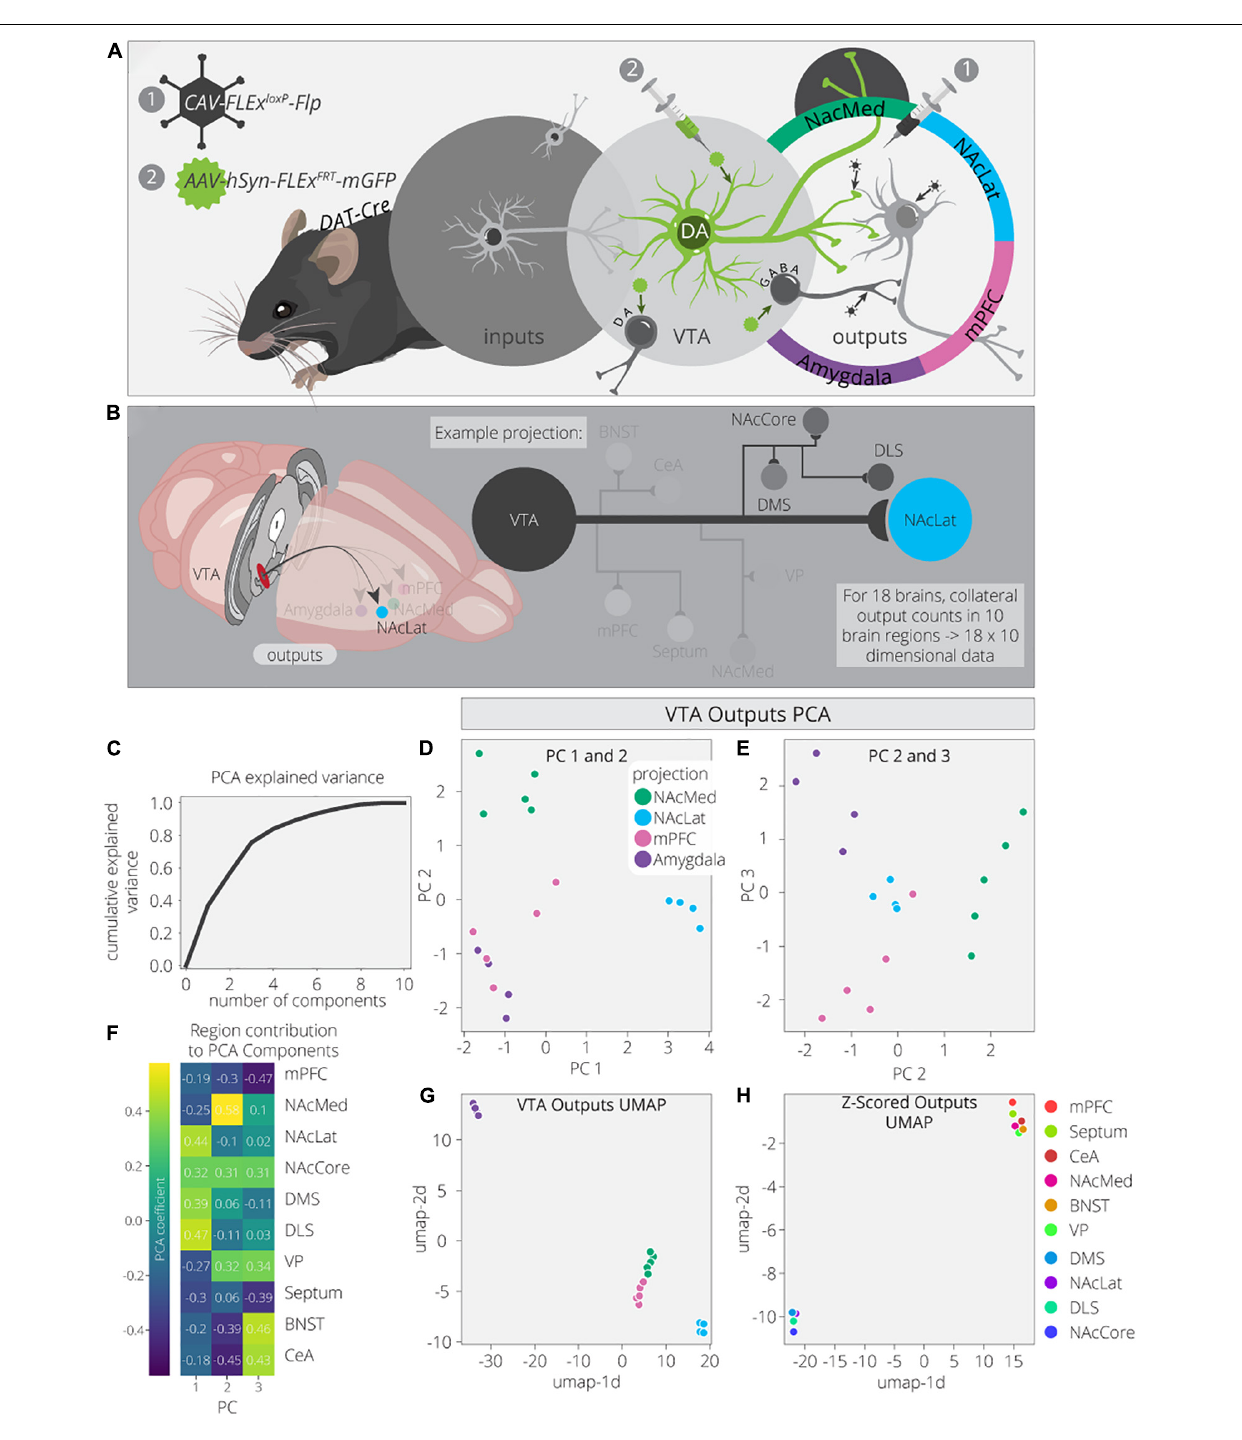
FIGURE 1 | VTA DA outputs are organized by four core projections. (A) Schematic for axonal arborization experiments. Viral injections were performed in DAT-Cre mice to label collaterals to VTA DA neurons projecting to a specified target. (B) Collaterals of VTA projections to the NAcMed, NAcLat, mPFC, and Amygdala were quantified in 10 brain regions across 18 mice. The NAcLat and its major collaterals are highlighted. (C) Cumulative explained variance from each principal component. (D) Brains are plotted in PCA space for the 1st and 2nd components, colored by projection. (E) Brains are plotted in PCA space for the 2nd and 3rd components, colored by projection. (F) Heatmap of each output region’s contribution to the first three principal components. (G) Brains are plotted in UMAP space, colored by projection. (H) Output regions are plotted in UMAP space, embedded with respect to z-scores across mouse brains. Clusters represent outputs with similar patterns of variation across the